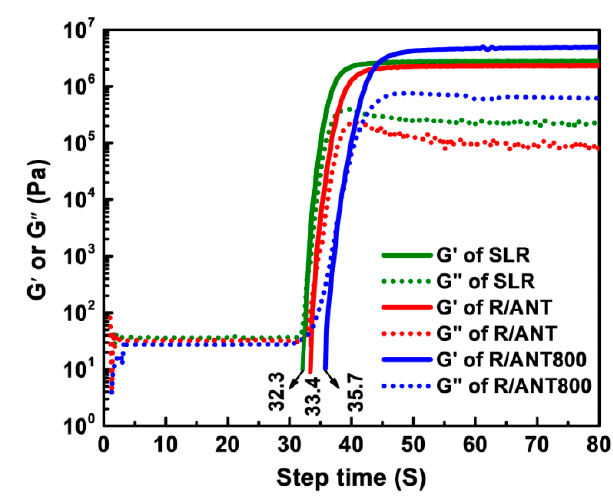
Figure 10. The effects of nanofillers on the kinetics of UV curing reaction. The solid and dotted lines represent storage modulus (G’) and loss modulus (G”) of the samples during the curing process, respectively.